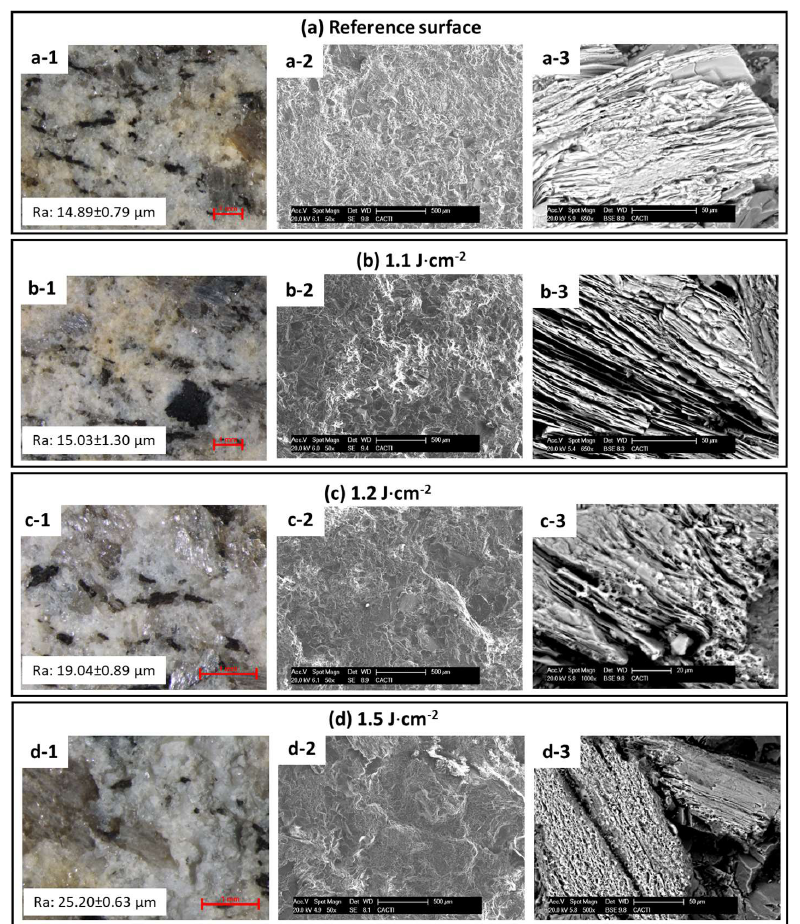
Figure 1. Micrographs obtained by means of stereomicroscopy ( 1 ) and SEM ( 2 and 3 ) of the reference granite ( a ) and the granite surfaces treated with a ns Nd:YAG laser at 1064 nm at different fluence values: ( b ) 1.1 J·cm −2 ; ( c ) 1.2 J·cm −2 and ( d ) 1.5 J·cm −2 . Images numbered with 1 show the arithmetic average height, Ra (µm) taken with confocal microscopy. Images numbered with 3 depict the biotite crystals in detail, in order to describe the absence or the presence of indicative melting textures. The scale bar of stereomicrographs is 1 mm.